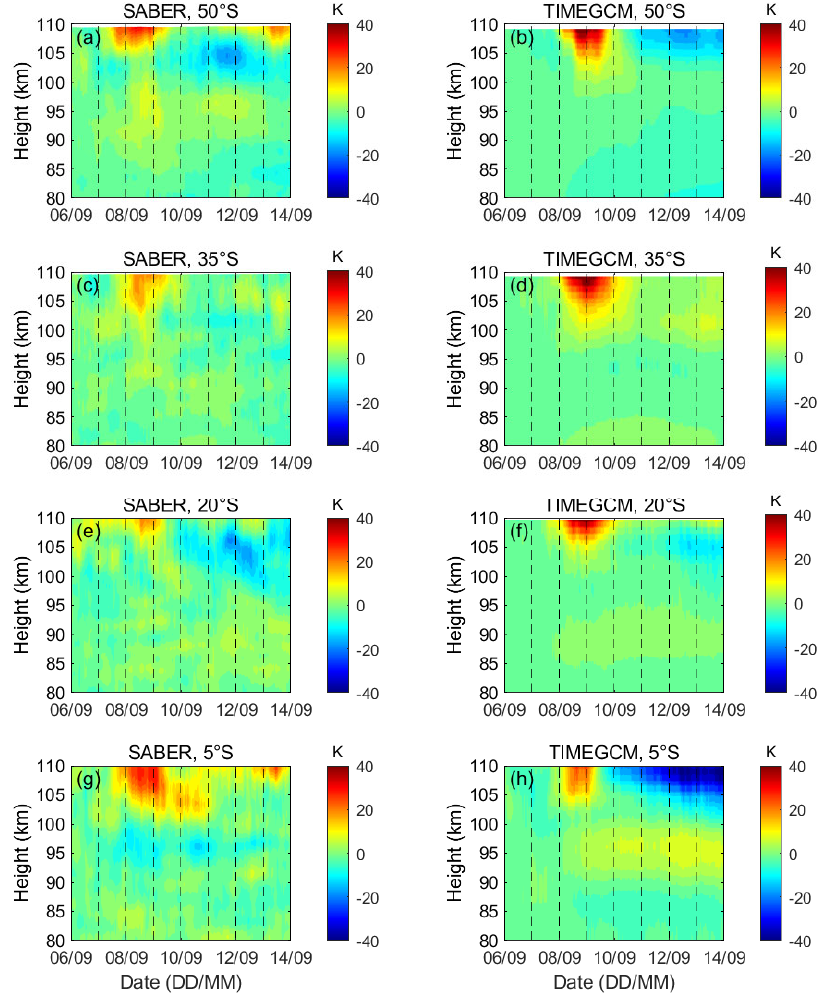
Figure 4. Same as Figure 2, but for a latitude range 50° S–5°S